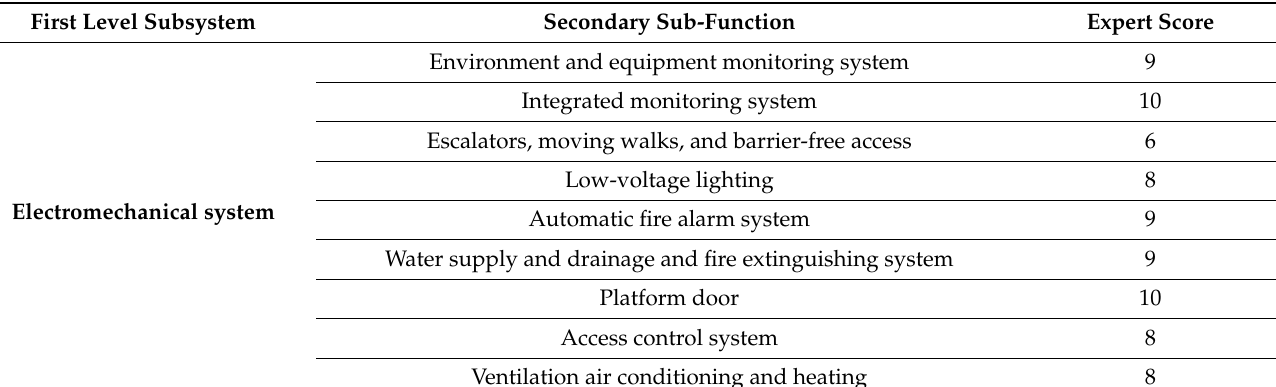
Table 5. The importance evaluation results of the electromechanical